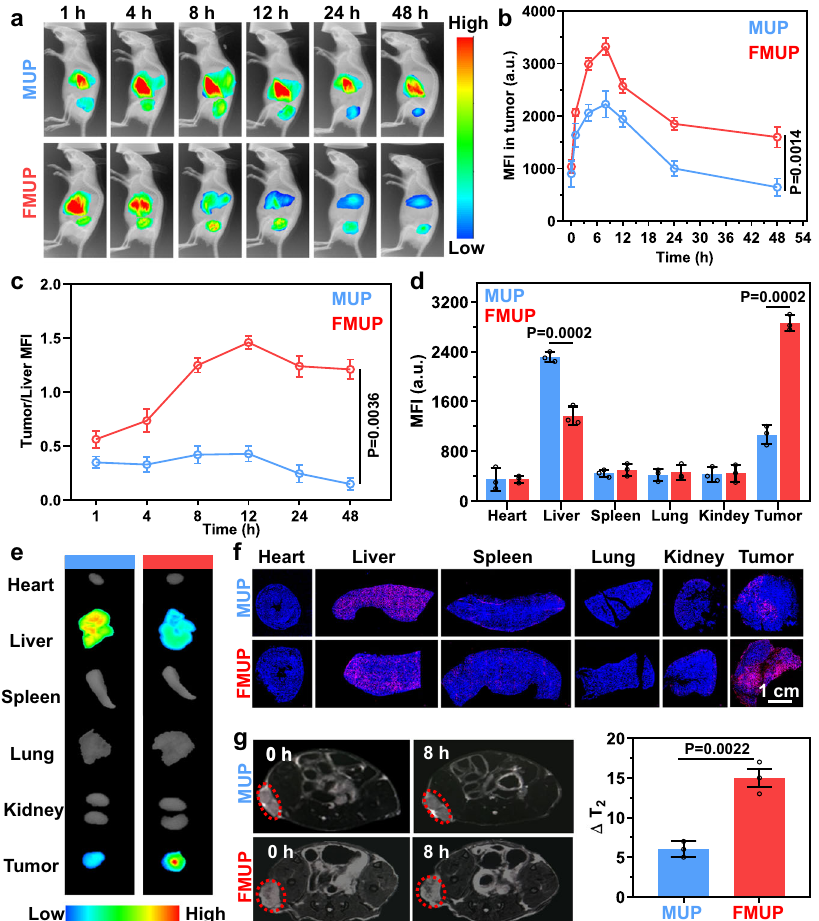
Fig. 6 In vivo biodistribution of MOF-based nanoagents. a In vivo fl uorescence imaging of biodistribution of MUP and FMUP in HeLa tumor-bearing mice over time. The color gradient represents the range from the minimum mean fl uorescence intensity (540) to the maximum fl uorescence intensity (4600). b The mean fl uorescence intensity of tumors in the group of MUP and FMUP with elapsing time. c The tumor/liver fl uorescence intensity ratios in the group of MUP and FMUP with elapsing time. d , e Ex vivo images of tumors and other main organs at 48 h postinjection and corresponding mean fl uorescence intensity analysis in the group of MUP and FMUP. The color gradient represents the range from the minimum mean fl uorescence intensity (810) to the maximum fl uorescence intensity (3300). f Frozen section staining images of main organs and tumors in MUP group and FMUP group. Red: Cy 5-lablled MOFs. Blue: nuclei. g T 2 -MRI images of mice before and after injection and corresponding analysis of △ T 2 value in the group of MUP and FMUP. Red dotted circles indicate the tumors. Data in ( b – d , g ) were represented as mean values ± SD, n = 3 biologically independent samples in ( b – d , g ). A representative image of three biologically independent samples from each group is shown in ( a , e , f , g ). P values were calculated by the two-tailed Student ’ s t test in ( b , d ,